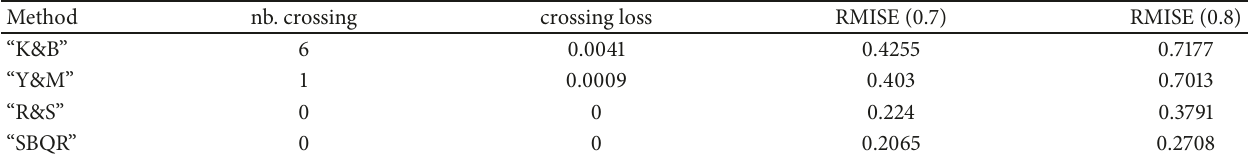
Figure 4: Estimated quantile curves (black solid lines) against the true ones (red dashed lines) for SBQR (left panel), F&R (middle panel), and M&ST (right panel) methods. Table 3: Table of criteria: crossing loss and RMISE for uniform covariate case.